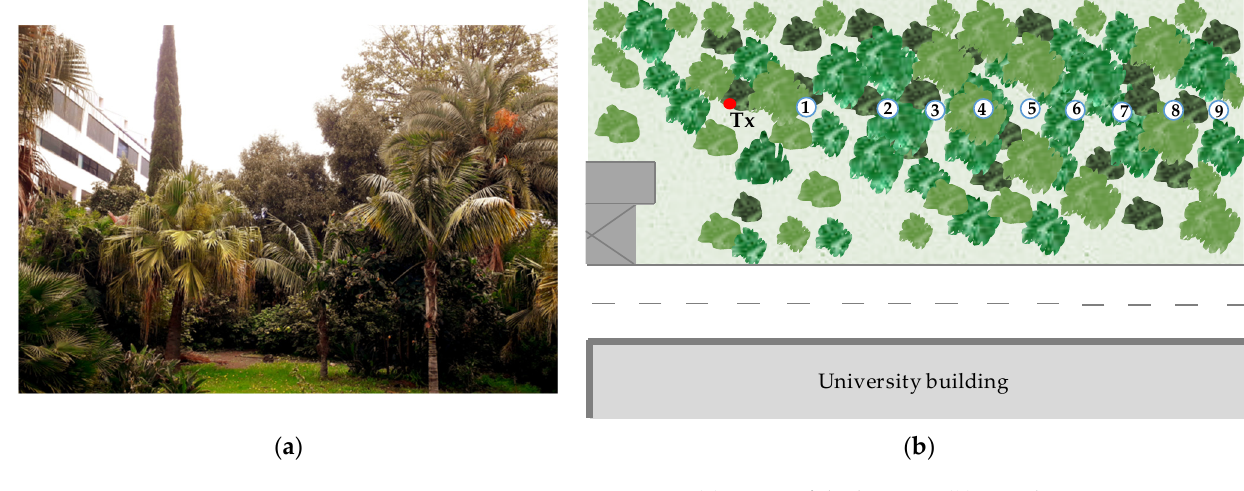
Figure 3. Location 3—vegetation zone: ( a ) image of the location; ( b ) site plan.